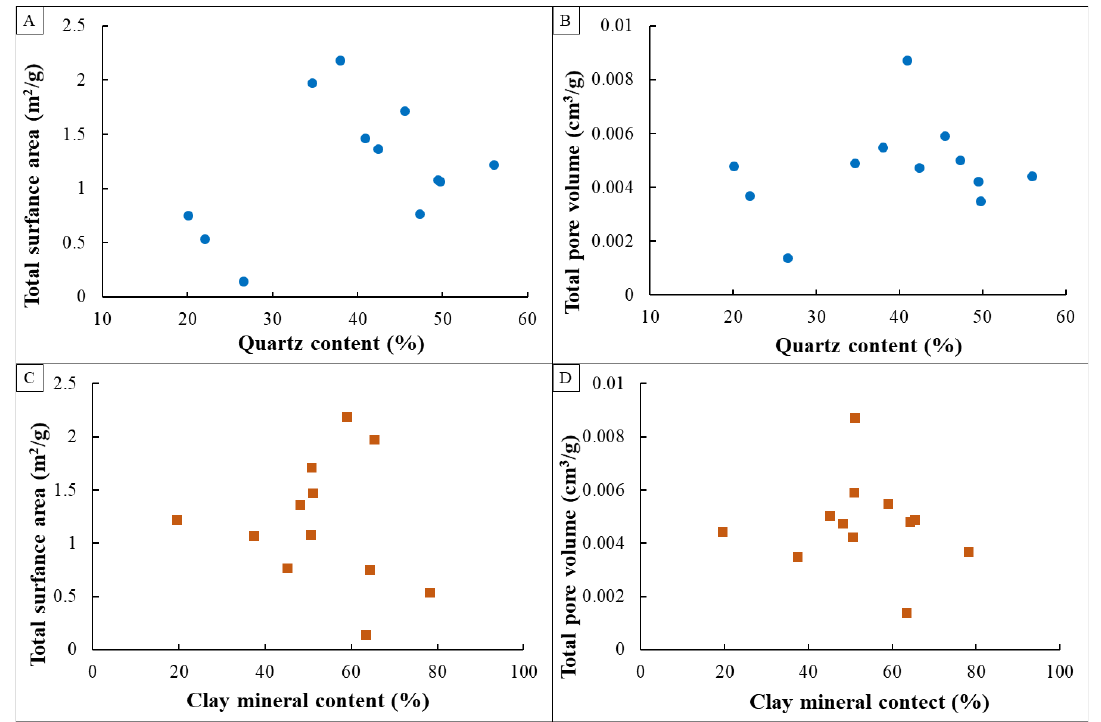
Figure 13. ( A ) Correlations between quartz content and total surface area of the shale in the study area. ( B ) Correlations between quartz content and total pore volume of the shale in the study area. ( C ) Correlations between clay mineral content and total surface area of the shale in the study area. ( D ) Correlations between clay mineral content and total pore volume of the shale in the study area.